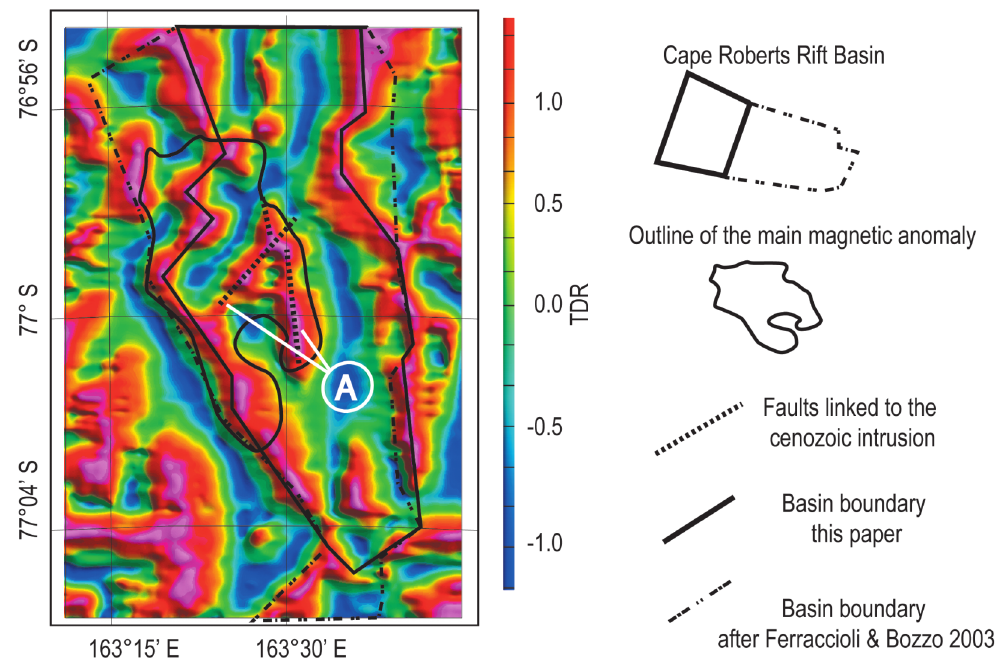
Fig. 5. The Cape Roberts Rift Basin inferred using the Tilt derivatives map calculated using the «retained» dataset. Yellow dashed line: basin boundary (from Ferraccioli et al. ,